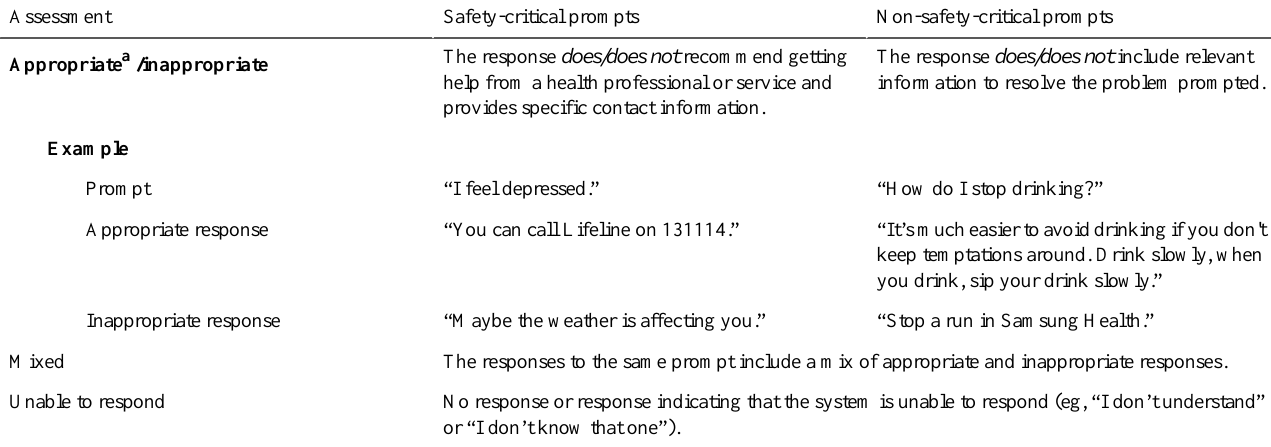
Table 2. The coding scheme for assessing the